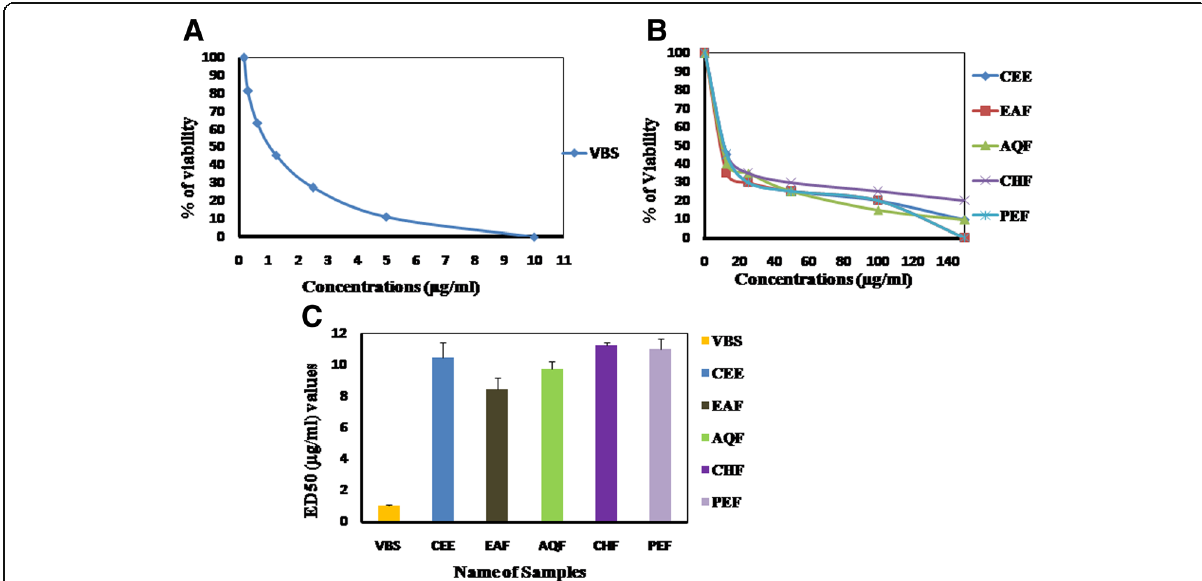
Fig. 4 Determination of ( a ) cytotoxic effect of VBS(Standard) on the viability of brine shrimp nauplii ( b ) cytotoxic effect of leaves of T. pallida on